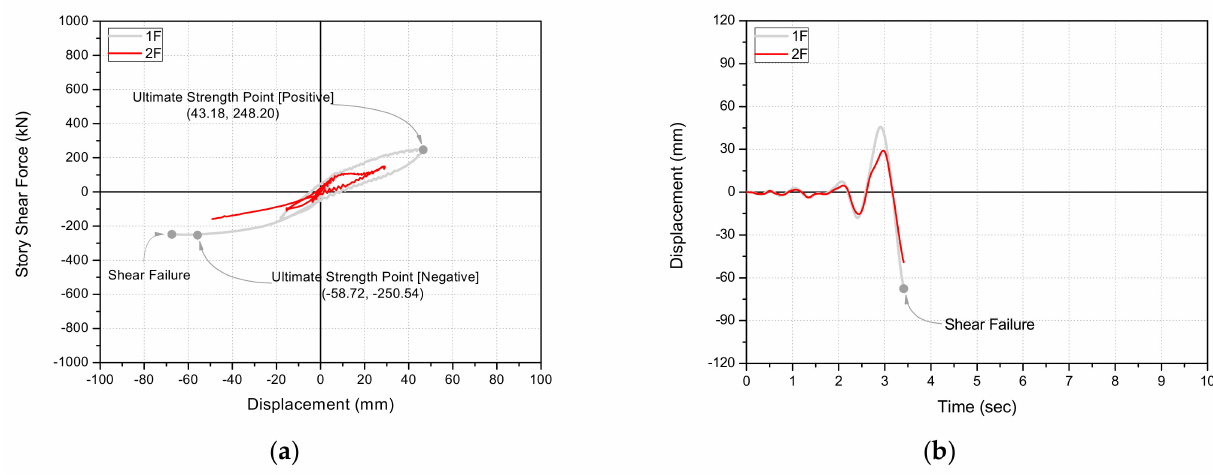
Figure 14. Seismic response load-displacement and displacement-time hysteresis curves (PD-FR, 200 cm/s 2 ): ( a ) load- displacement curves; ( b ) displacement-time hysteresis